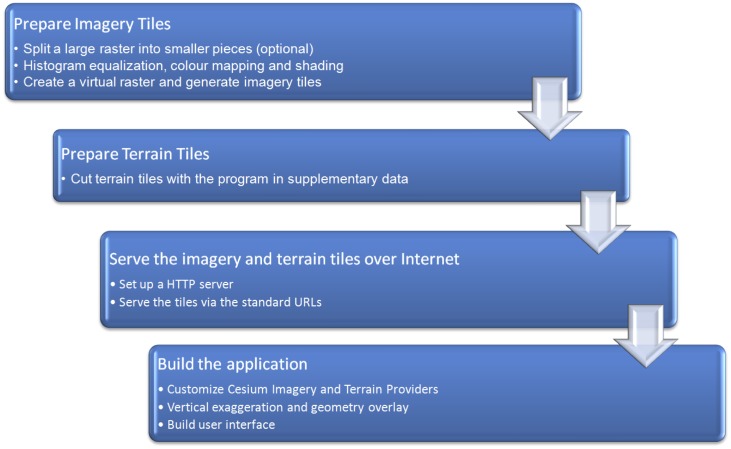
Workflow for designing a virtual globe.The details involved in this workflow are summarized in S1 Text.